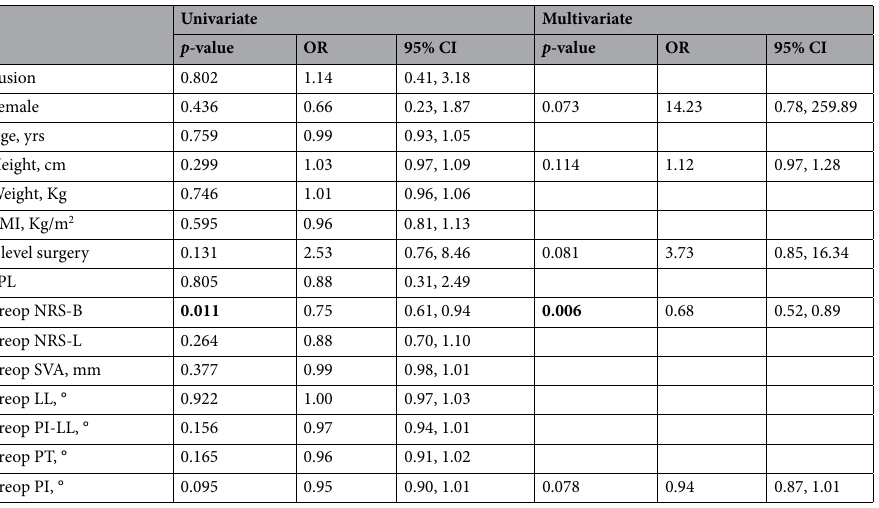
Table 4. Risk factors for the non-improvement of ODI* at postoperative 2 years. SPL spondylolisthesis, Preop preoperative, NRS-B numerical rating score of pain on back, NRS-L numerical rating score of pain on leg, SVA sagittal vertical axis, LL lumbar lordosis, PI-LL difference between pelvic incidence and lumbar lordosis, PT pelvic tilt, PI pelvic incidence, OR odds ratio, CI confidence interval. Nagelkerke R 2 statistic = 0.284 and Hosmer and Lemeshow goodness of fit test was not significant at 5% ( P = 0.792). *The minimal clinically important difference of Oswestry disability index was set as 8/50 21,22 . Boldface type indicates statistical